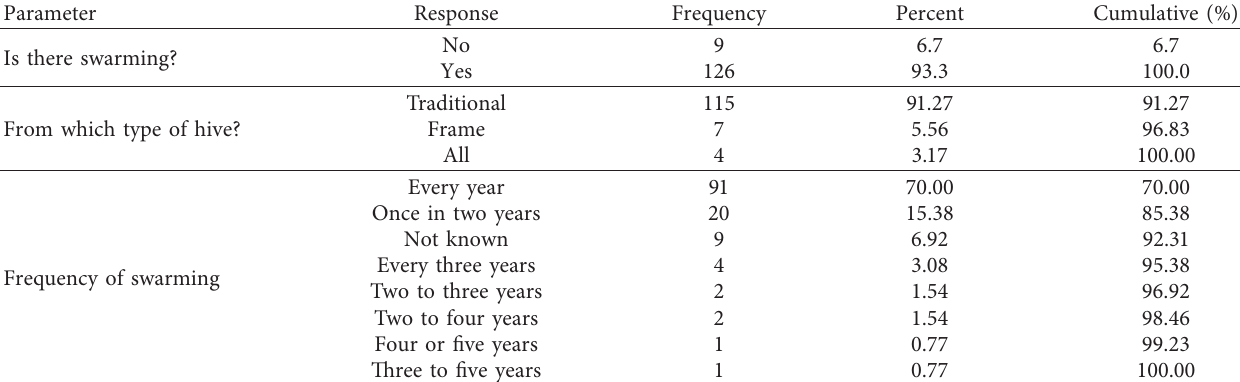
Table 9: Beekeepers response to reproductive swarming of honeybees in the study areas.